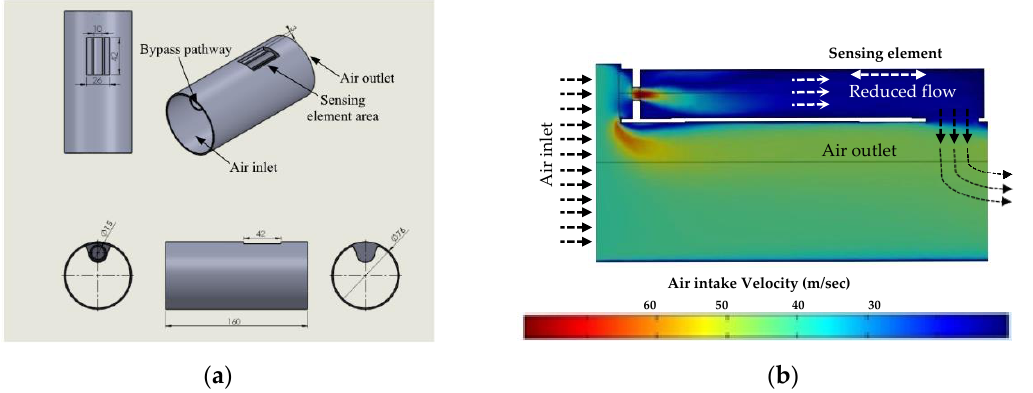
Figure 2. ( a ) Schematic of the housing geometry; ( b ) corresponding simulation results for the developed flow [12].